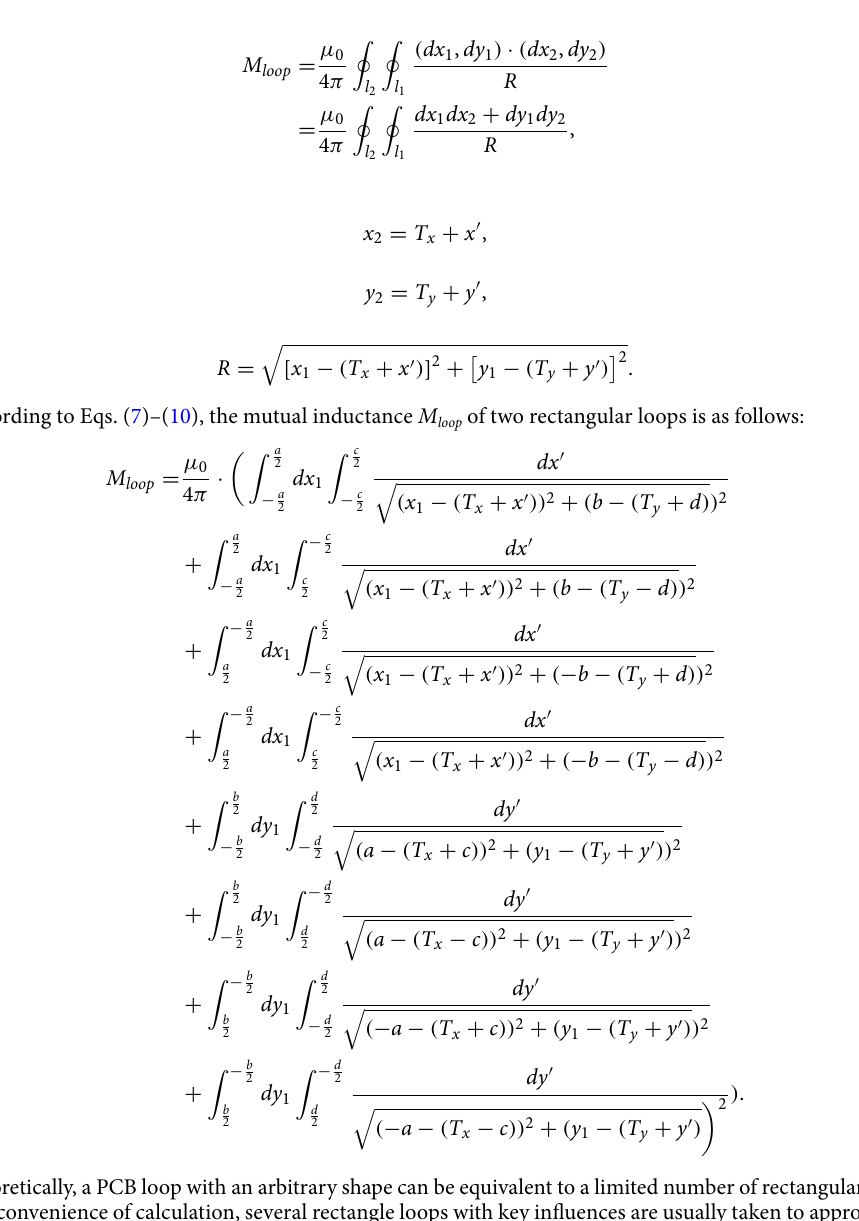
Figure 17. Mutual inductance between primary power PCB loop and plug